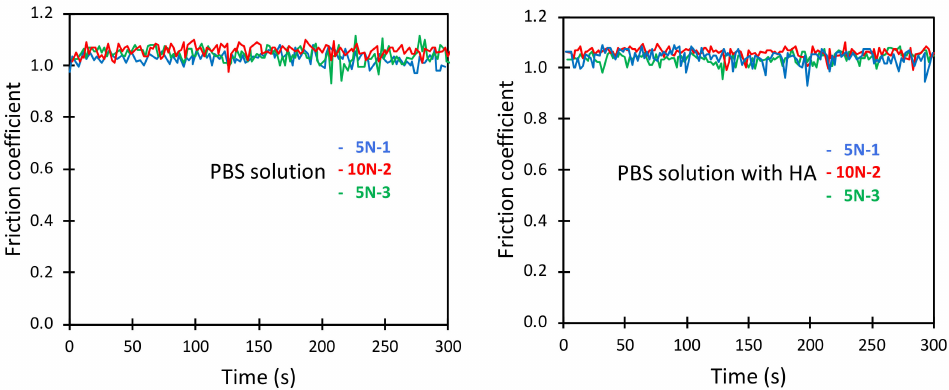
Figure 4. Friction coefficient between borosilicate surfaces across PBS solution ( left panel) and across PBS solution containing 0.5 mg/mL HA ( right panel) as a function of time. Numbers 1, 2 and 3 displayed after the load (5 N or 10 N) report the order in which the load was